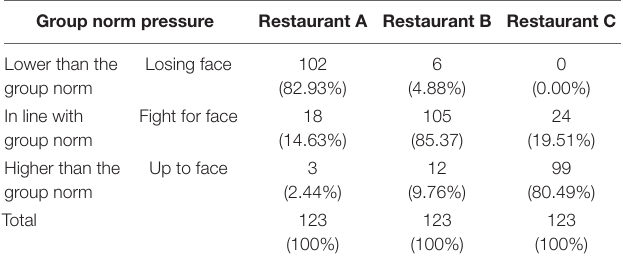
TABLE 4 | Consumer choice statistics of target